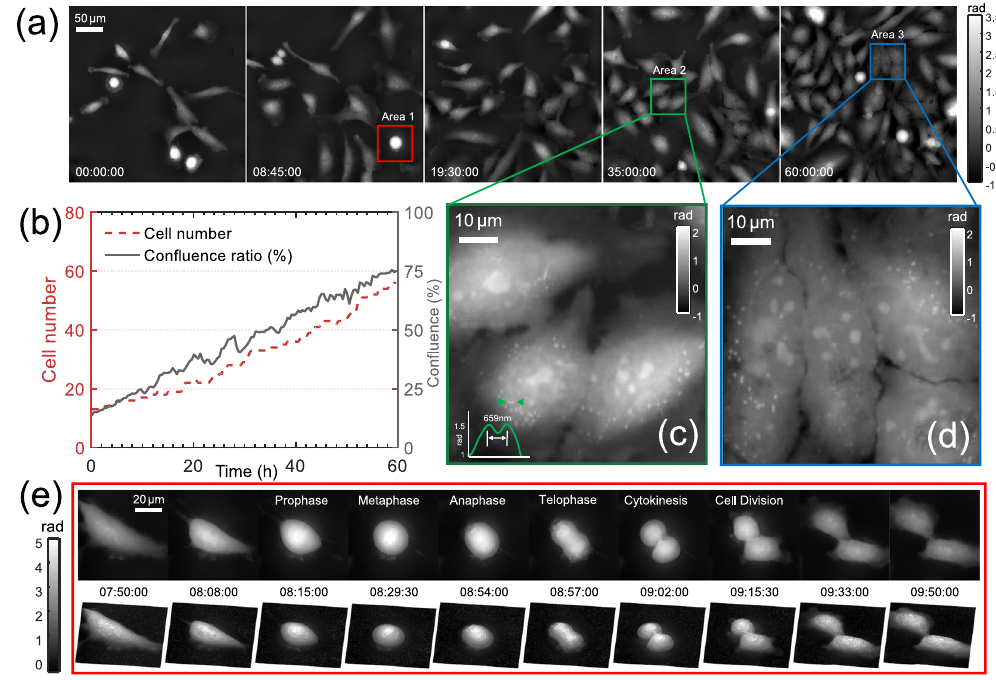
Figure 14. Time-lapse phase imaging of HeLa cell division over a long period (60 h). ( a ) Representative quantitative phase images at different time points. ( b ) The change of cell number and confluence ratio over the culture passage period. ( c ) and ( d ) show the magnified views corresponding to two regions of interest (Area 2 and Area 3). ( e ) 10 selected time-lapse phase images and the corresponding 3D renderings showing the morphological features of a dividing cell (Area 1) at different stages of